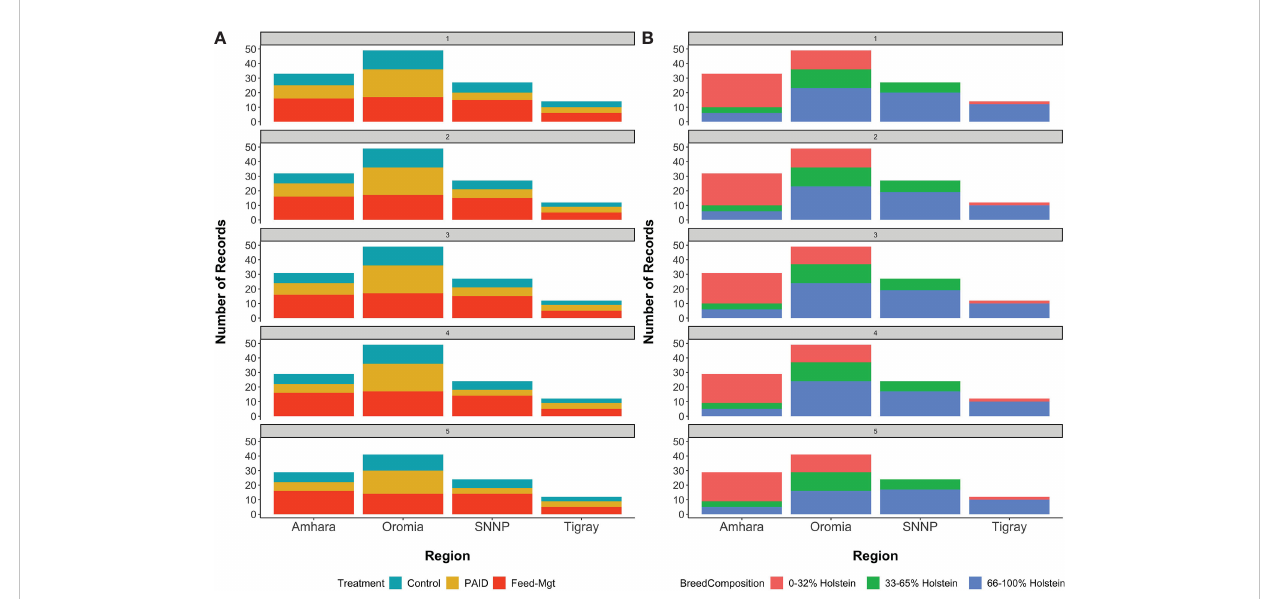
FIGURE 3 Number of records in each region per treatment (Plot A) and per breed composition (Holstein-Friesians; Plot